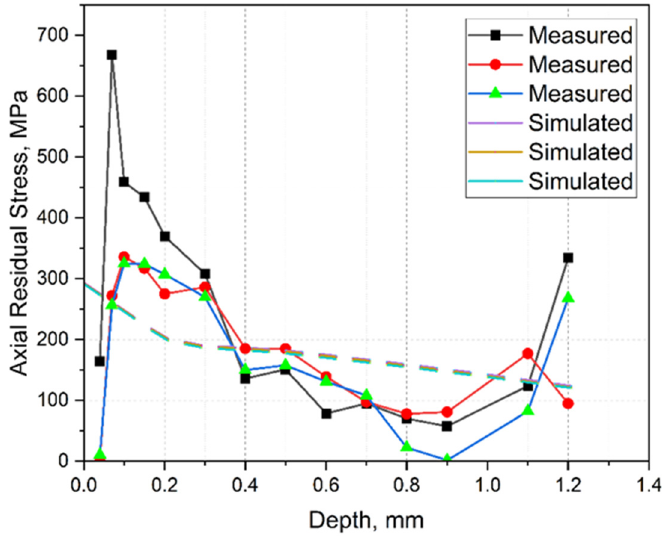
Figure 12. Comparison between the simulated and measured residual stress.